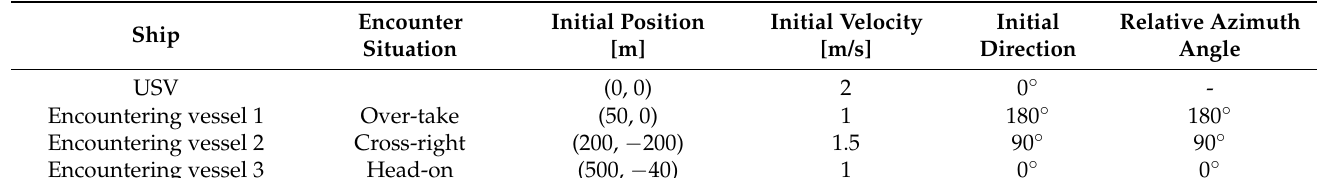
Table 9. Critical moment collision threat degree assessment results.